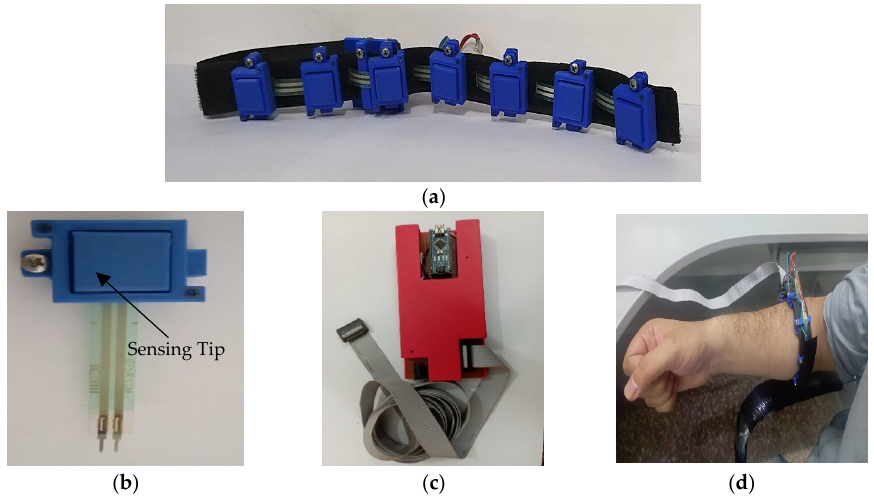
Figure 2. ( a ) FMG armband with 7S sensors, ( b ) 3D printed sensor, ( c ) Data acquisition hardware, and ( d ) LD ‐ FMG band fastened on individual’s forearm.